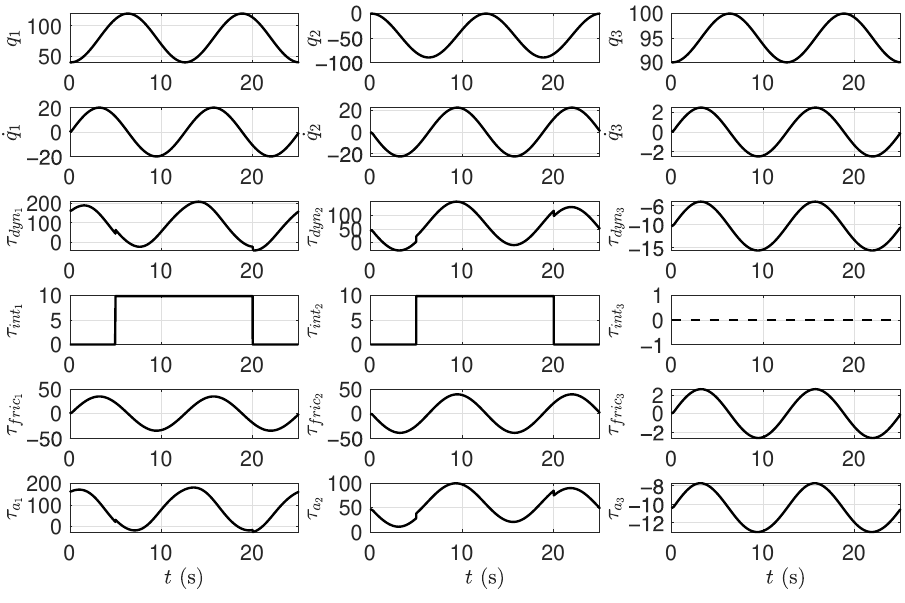
Figure 9. LLRR dynamics during a leg press